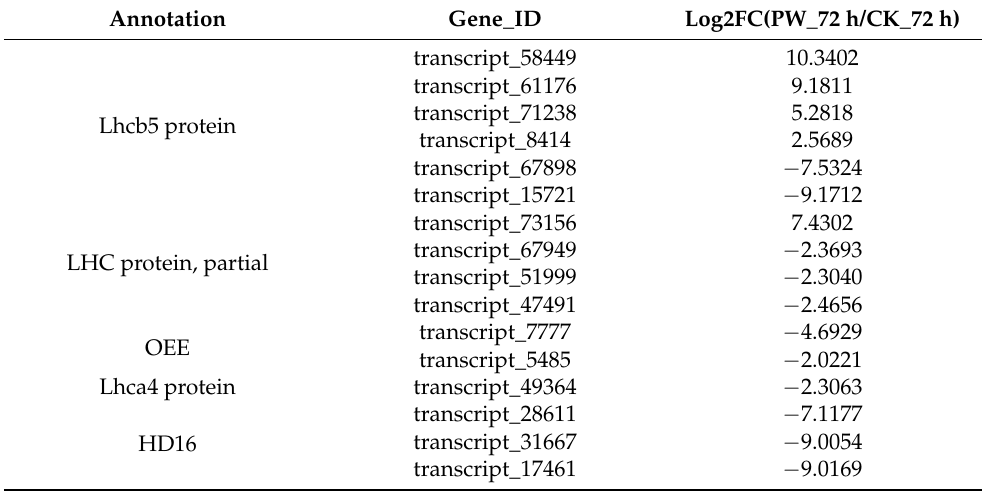
Table 5. DEGs expression under wounding stress of Mongolian